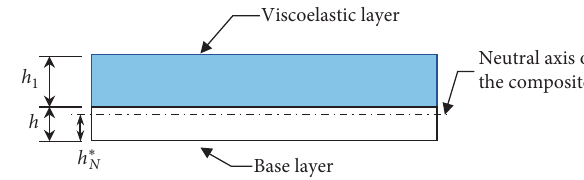
Figure 2: The neutral axis of the composite